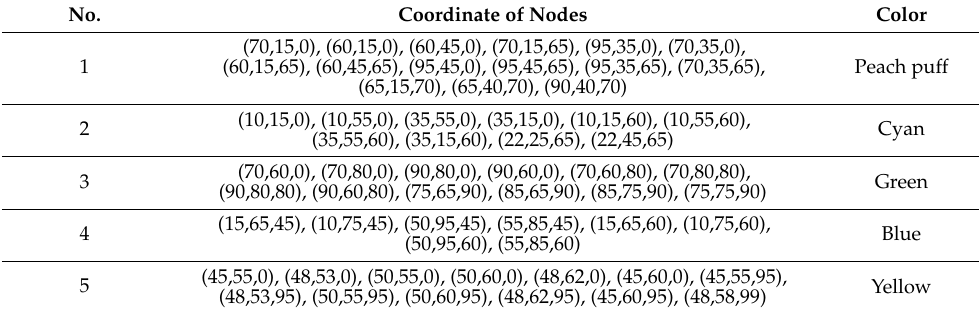
Table 1. Distribution of